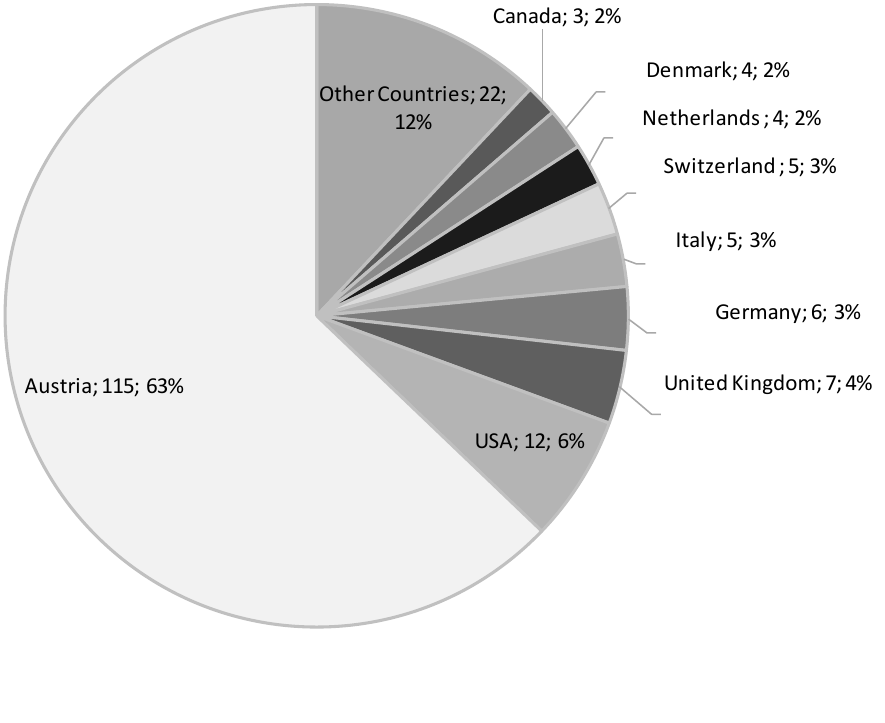
Figure 1. Countries of Residence of Participants (Other countries with only 1-2 participants each were: AGO, ALB, ATA, CZE, ESP, FRA, HUN, LTU, LUX, NOR, PHL, URY, AUS, BEL, BGR, IRL, RUS) (Source: